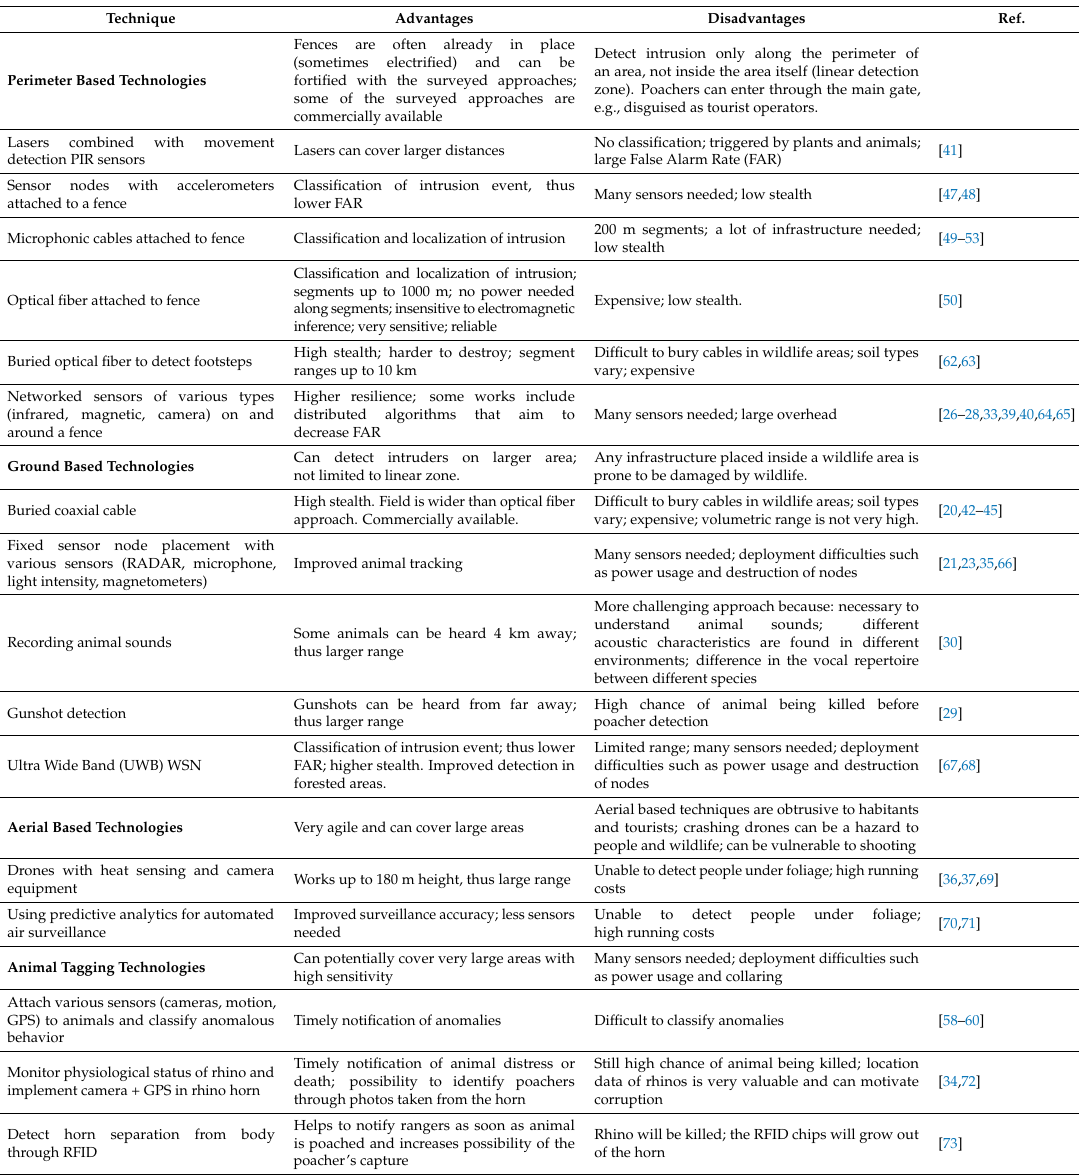
Table 3. Overview of poaching detection